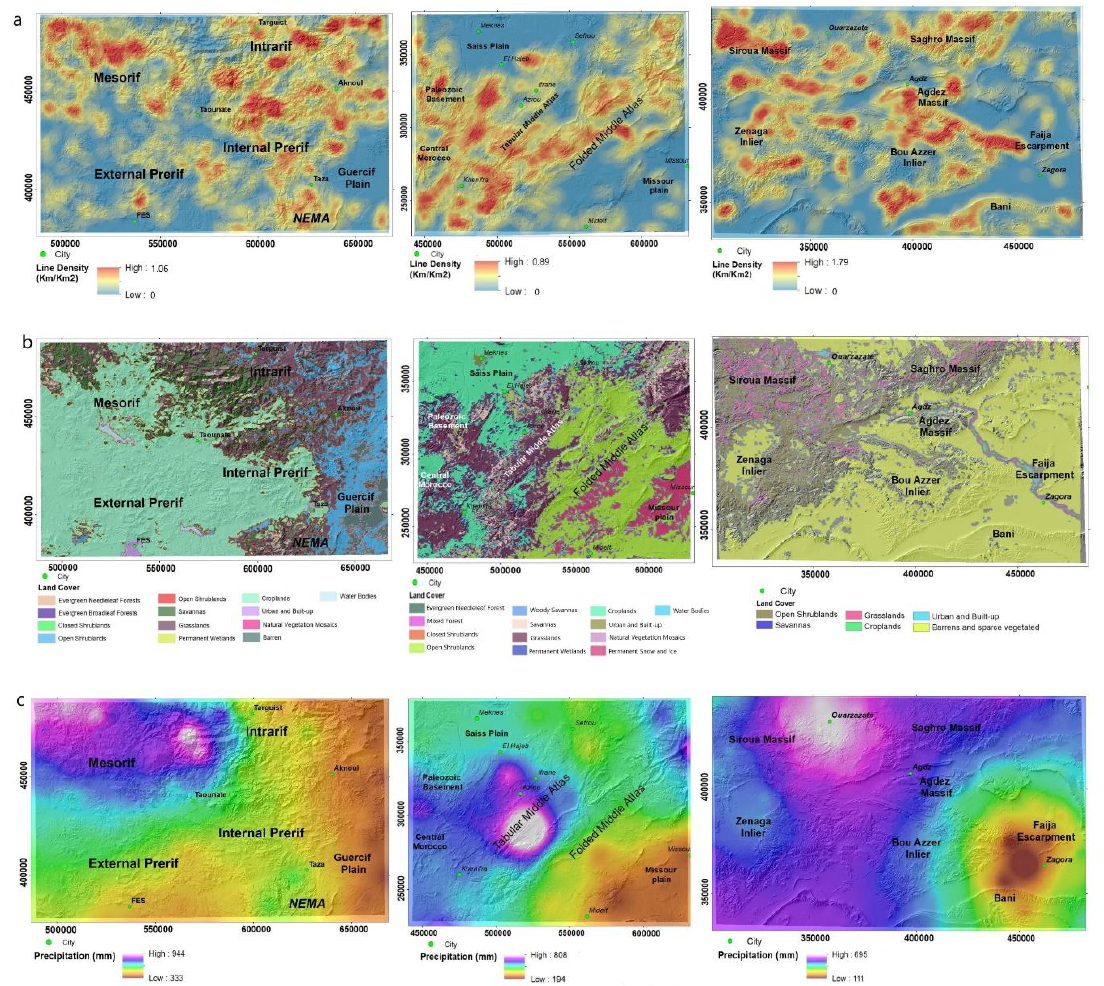
Figure 5. Spatial distribution of ( a ) lineament density, ( b ) land cover, and ( c ) precipitation, from left to right for the External Rif, the Middle Atlas and Central Anti-Atlas.